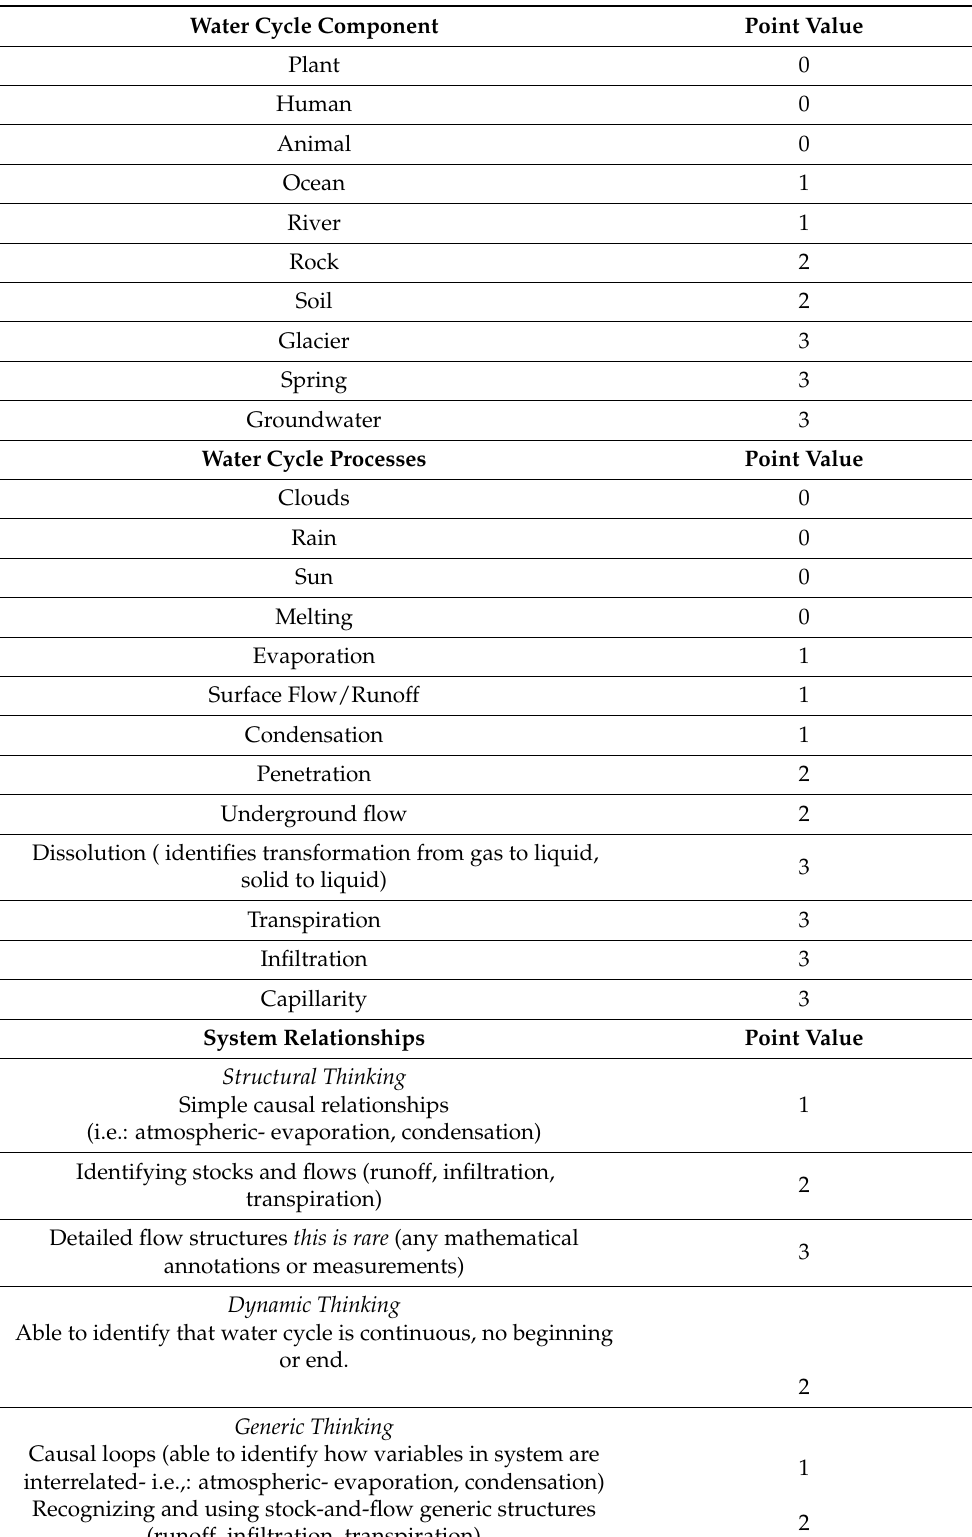
Table A3. Drawing Assessment